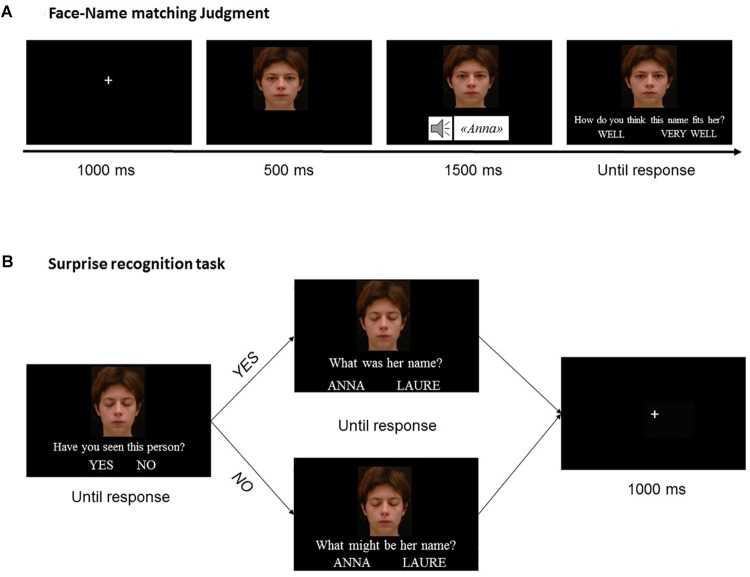
Illustration of the experimental design. (A) Illustration of an experimental trial of the Study Phase. During the study phase, subjects were presented with faces displaying either direct or averted gaze in association with a name presented orally and performed a Face-Name matching task (i.e., they indicated whether the name fitted “Well” or “Very well” the face it was associated to). (B) Illustration of an experimental trial of the Test Phase. After a 5-min interfering task, participants were asked to perform a surprise recognition test for each pair of stimuli, in a sequential fashion (i.e., the face first, then the name). They were asked to perform an Old-New recognition task over faces, followed by a forced-choice recognition task over names. As for name recognition, two possible questions could be displayed, depending on participants’ previous answer (whatever it was correct or not). If they indicated that they actually recognized the face shown on the screen, they were asked “What was his/her name?” If they reported to never have seen the face before, the displayed question was “What might be his/her name?” Written informed consent was obtained from the depicted individual presented in (A,B) for the publication of his identifiable images.